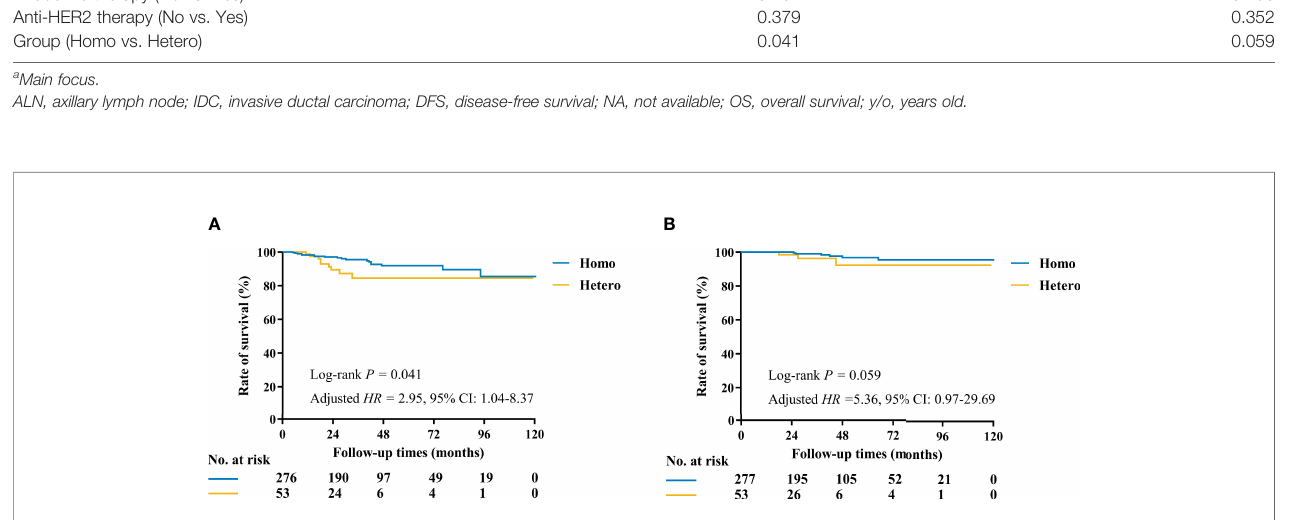
FIGURE 3 | Kaplan – Meier curves of DFS and OS by molecular markers status among 330 patients with at least two invasive tumor foci. (A) The estimated 3-year DFS rates for the Homo and Hetero groups were 96.5% and 81.2%, respectively ( p = 0.041). (B) The estimated 3-year OS rates for the Homo and Hetero groups were 99.5% and 95.8%, respectively ( p =